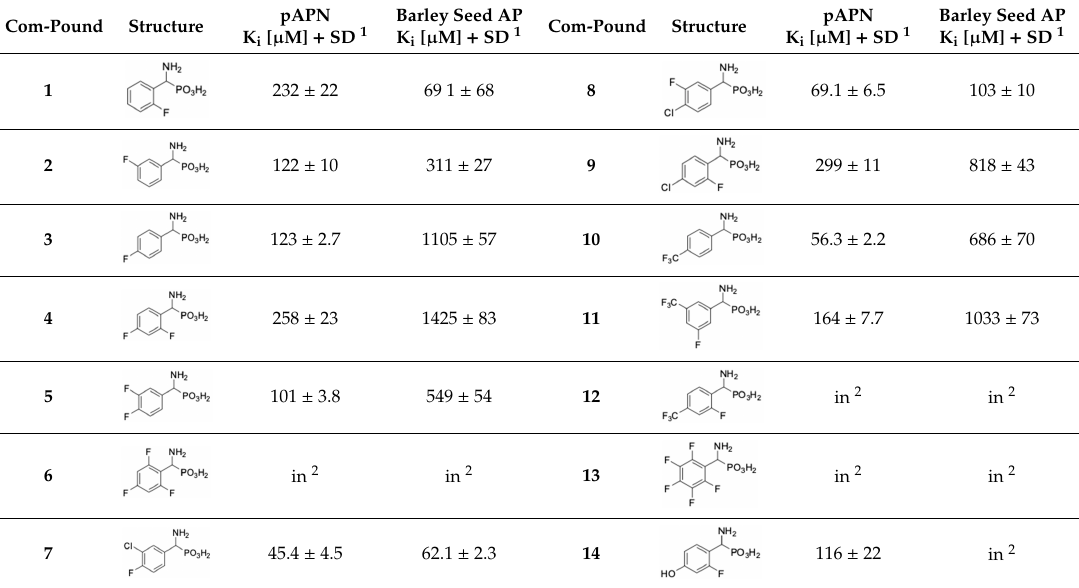
The binding mode of the studied inhibitors to pAPN was further studied by molecular modeling. In the first step of the procedure, the poses docked at the distance of 20 Å from the centroid metal ion were considered. The computed induced fit docking algorithm indicated which of the amino acids were well scored, and these were therefore considered in the next step (see Tables S1 and S2 in the Supplementary Information). The nature of the binding of phosphonic acid analogues of phenylglycine to pAPN was, with the exception of compounds 13 and 14 , highly uniform (Figure 1). Obviously, the dominant component of the total interaction energy was the electrostatic one between the phosphonate anion and zinc cation. Thus, the phosphonate group was involved in bidental zinc ion complexation and additionally formed hydrogen bonds with Tyr472. A strong hydrogen bond was also formed between Glu384 and the amine moiety of the inhibitor. This pattern of interactions was primary responsible for the binding of all the studied compounds. The main feature of pAPN is its hydrophobic S1 pocket, which binds N-terminal hydrophobic amino acids of hydrolyzed peptides and proteins. Mainly, side chains of Ala348, Ala361, and Val 380 form this spacious pocket. The placement of aromatic portions of inhibitors in this binding site has a significant effect on inhibition. Thus, aromatic fragments of individual phenylglycine analogs filled this spacious pocket (with the exception of compounds 13 and 14 ) in a slightly different manner,